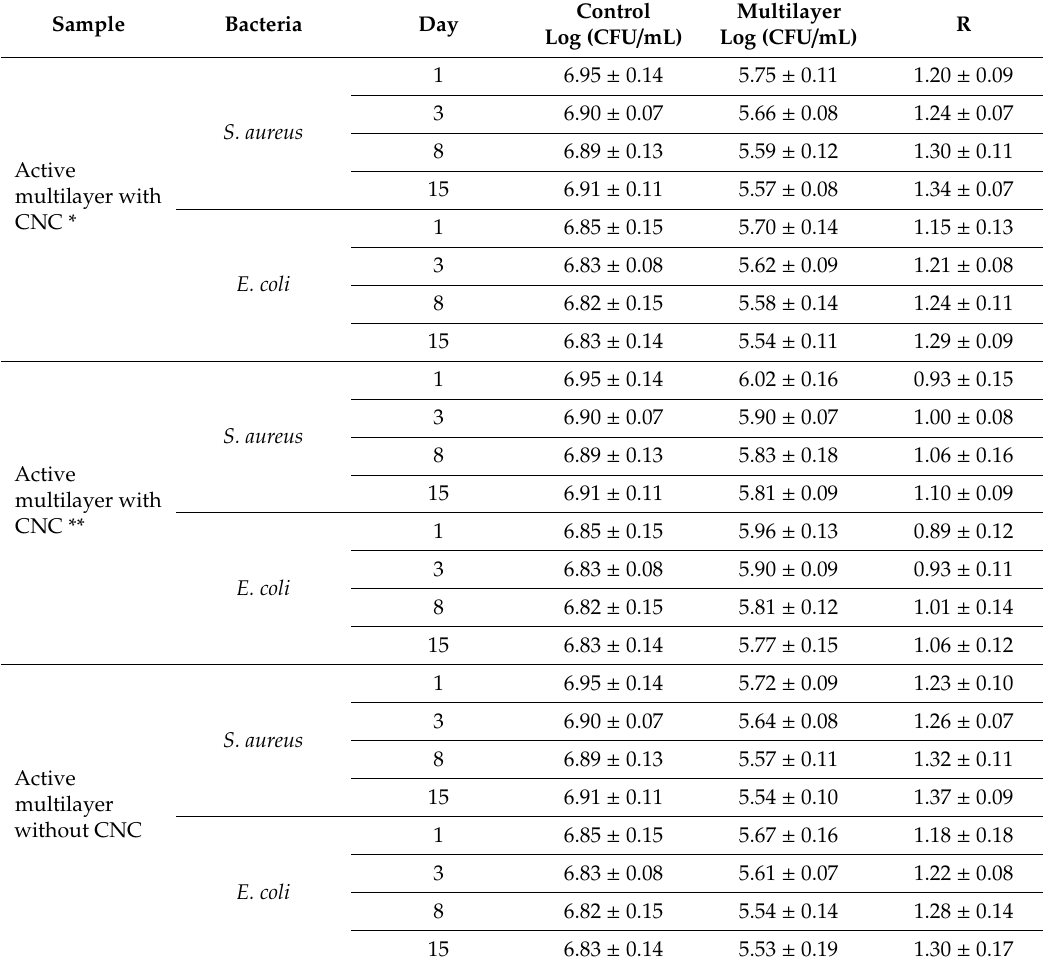
Table 5. Antibacterial activity against Staphylococcus aureus ( S. aureus ) and Escherichia coli (E. coli) of the active multilayer films with and without cellulose nanocrystal (CNC) coatings in the closed system for 15